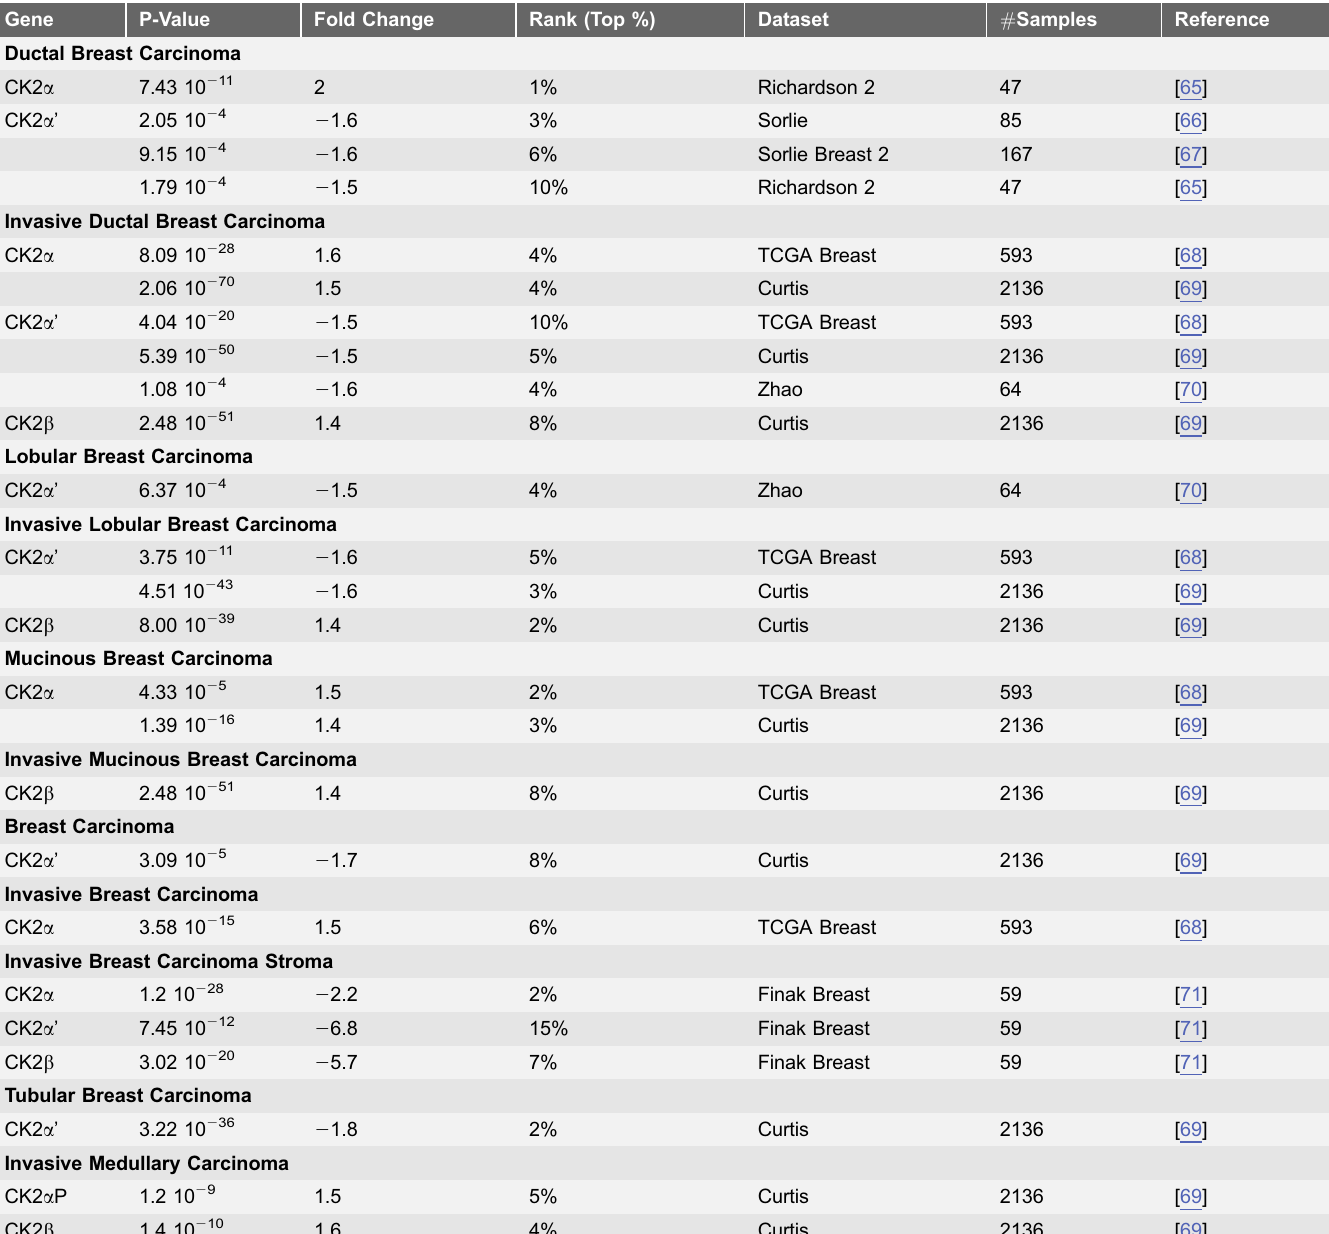
Table 2. Changes in CK2 gene expression in breast cancer. Gene P-Value Fold Change Rank (Top %) Dataset # Samples Reference Ductal Breast Carcinoma